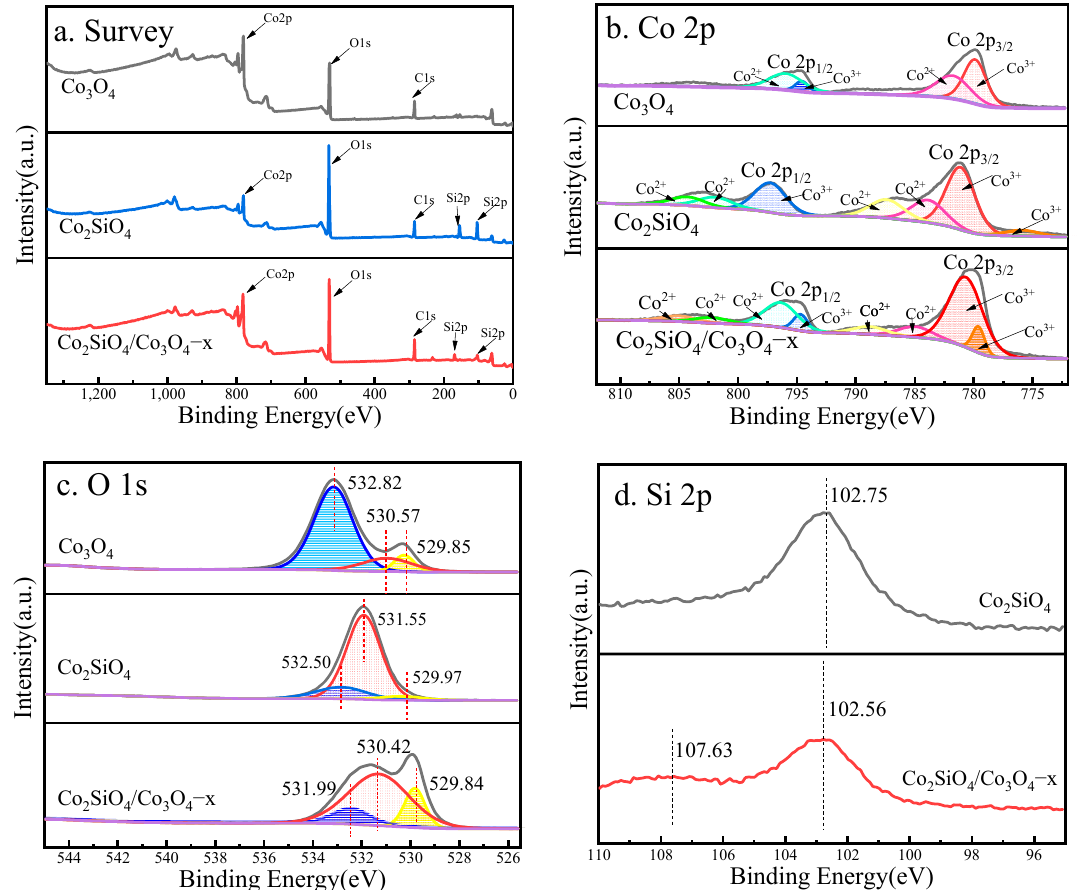
Figure 4. XPS spectra of Co 3 O 4 , Co 2 SiO 4 , and Co 2 SiO 4 /Co 3 O 4 − x: ( a ) survey spectrum, ( b ) Co 2p, ( c ) O 1s, and ( d ) Si 2p.